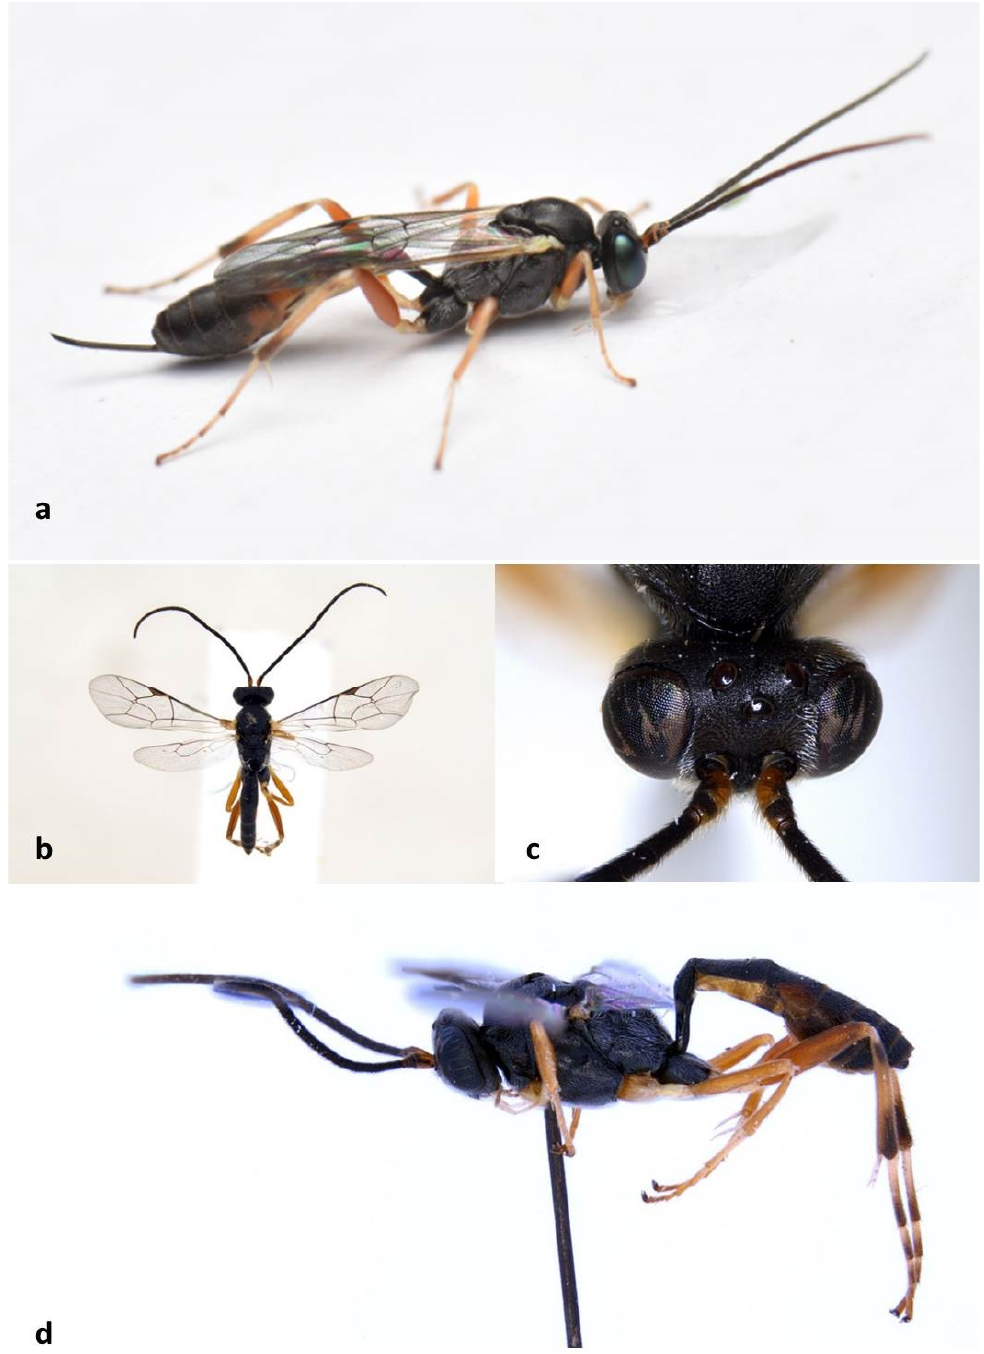
Figure 6. Herpestomus brunnicornis, a natural enemy of Yponomeuta meguronis : ( a ) ecological photo; ( b ) dorsal view; ( c ) head; and ( d ) lateral view.